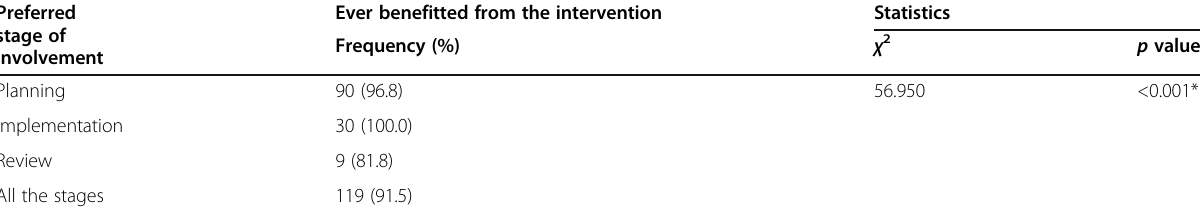
Table 6 Respondents desire to participate in the intervention against ever benefitting from any intervention in the camp ( n =278) Preferred stage of